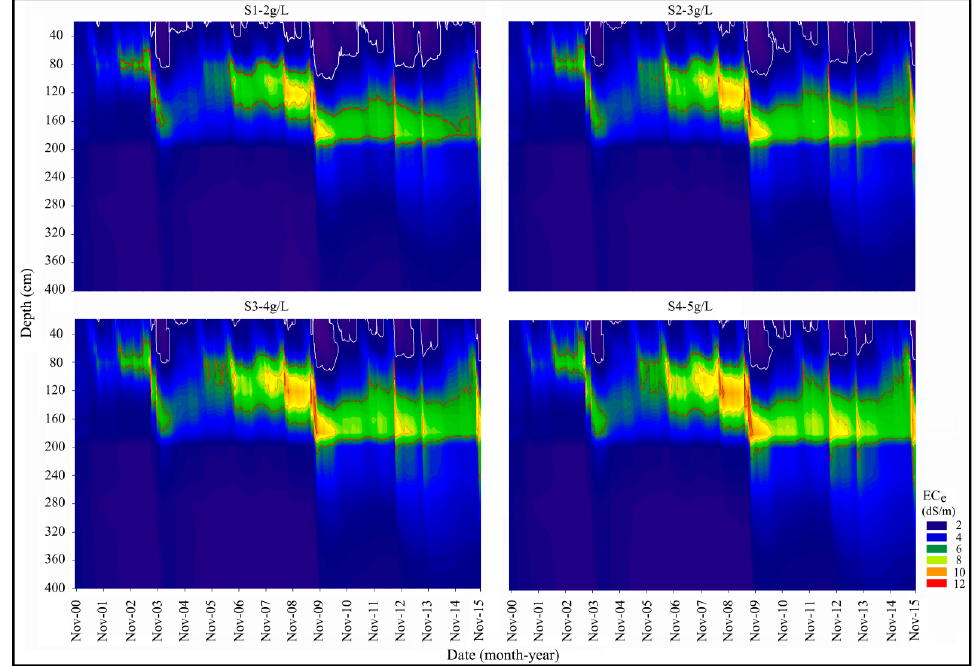
Figure 4. Electrical conductivity of saturated soil extracts at different depths under the four simulated irrigation scenarios in the Hebei Low Plains study area in North China. White and red lines represent respective salt tolerance thresholds of summer maize and winter wheat.